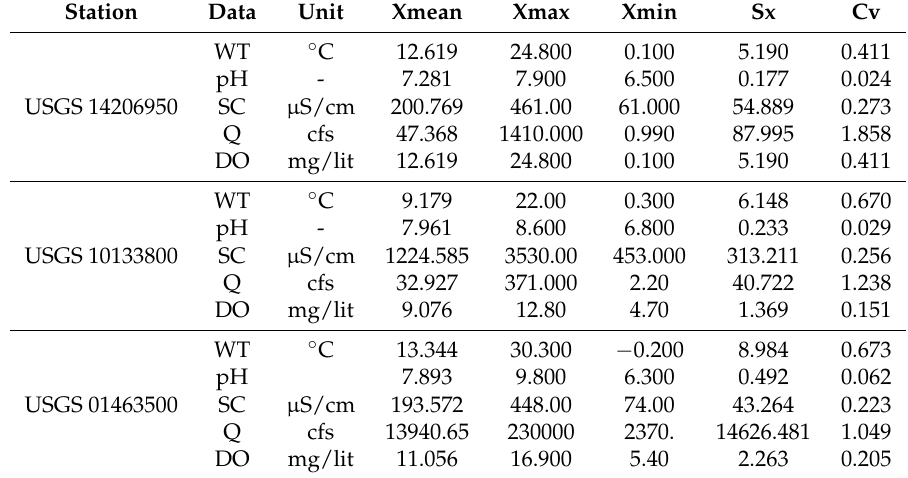
Table 2. The statistical properties of the water quality variables used in this study at the three investigated monitoring